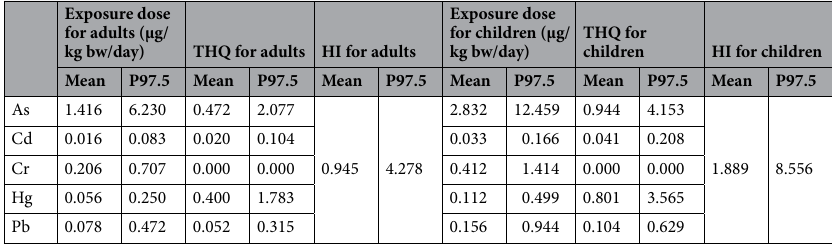
Table 5. Estimated exposures to As, Cd, Cr, Hg and Pb for consumption of marine fish from Zhejiang province.